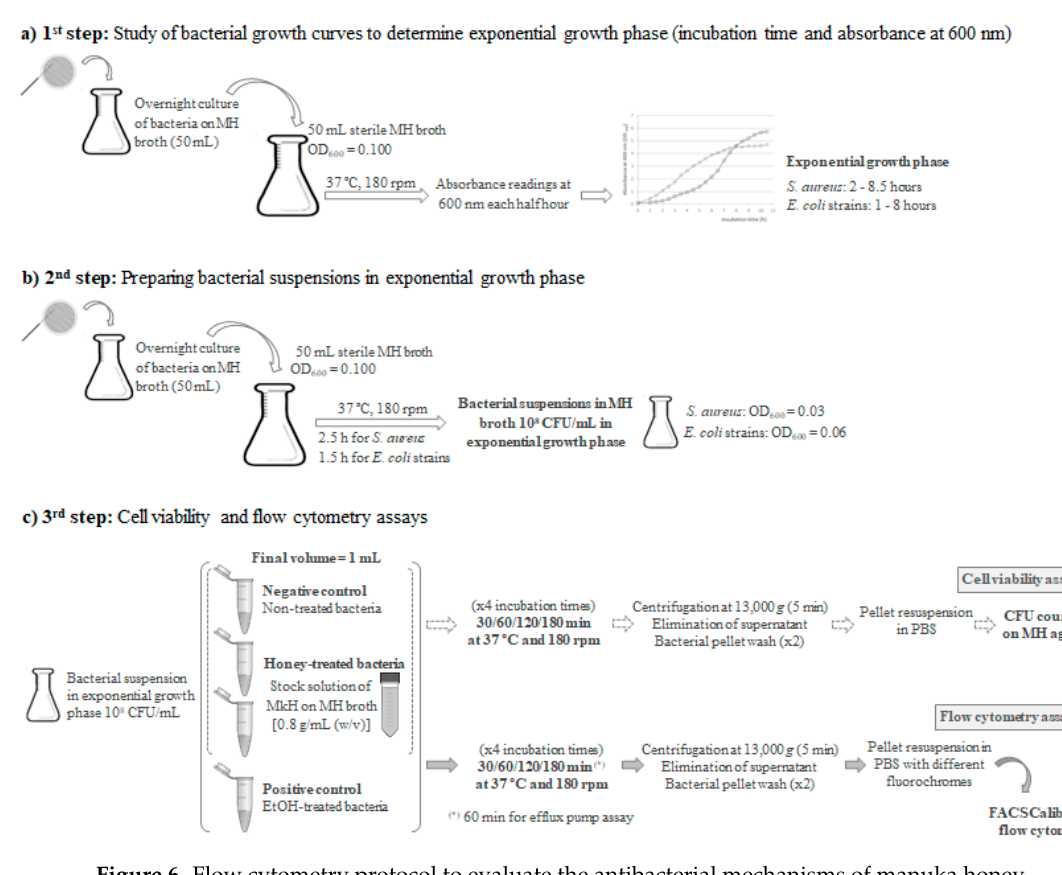
Figure 6. Flow cytometry protocol to evaluate the antibacterial mechanisms of manuka honey.